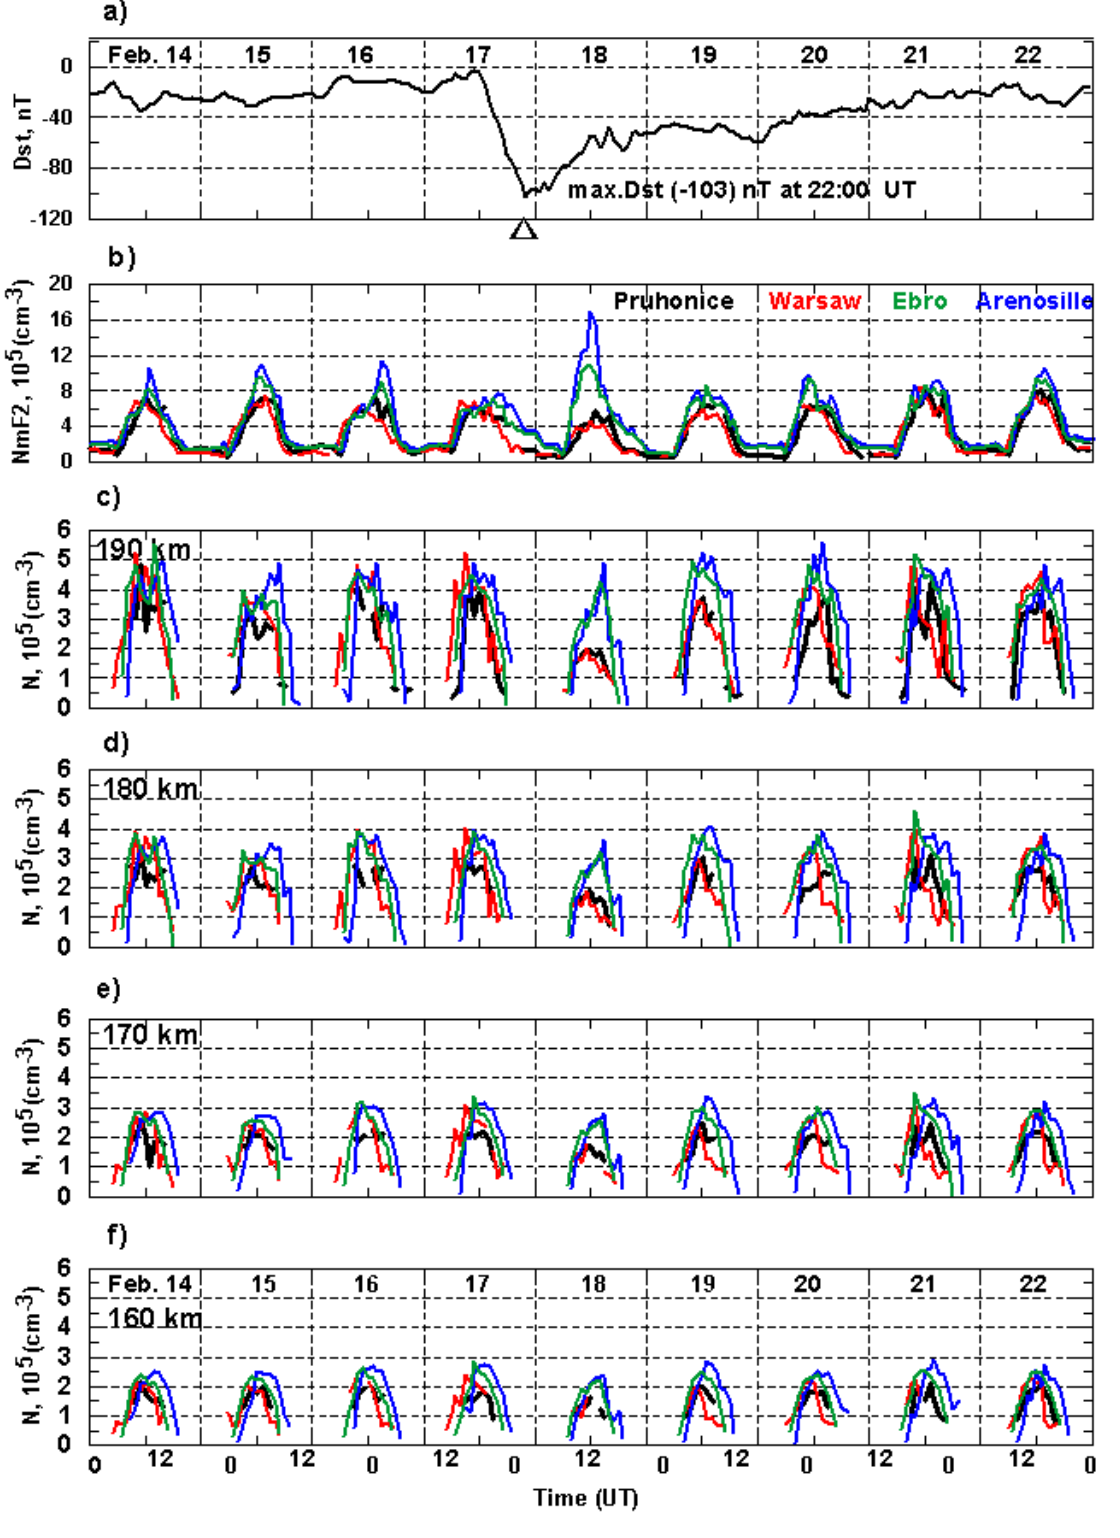
Fig. 4. Storm of February 1998: (a) hourly D st indices, (b) hourly Nm F2 values for Pruhonice, Warsaw, Ebro and Arenosillo, (c–f) electron density at 190, 180, 170 and 160km, respectively, for daytime hours for all stations. Time is in